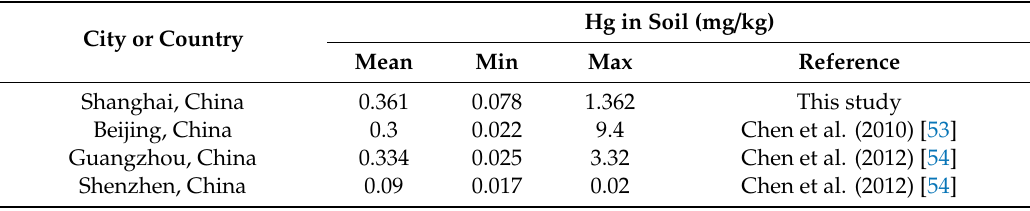
Table 3. Mean, minimum, and maximum concentrations of mercury (mg / kg) in soil and road dust in some